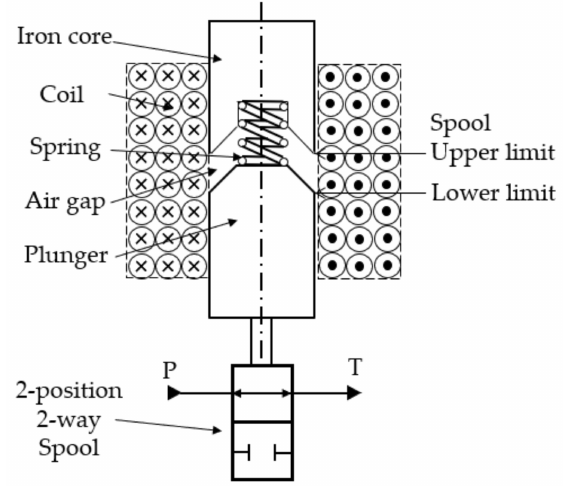
Figure 1. Structure diagram of a SV08-25 solenoid-operated on–off